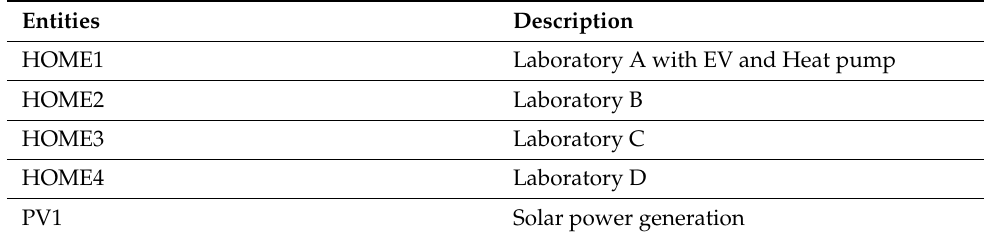
Table 2. Composition of Consumers and Generators in the Demonstration Experiment.